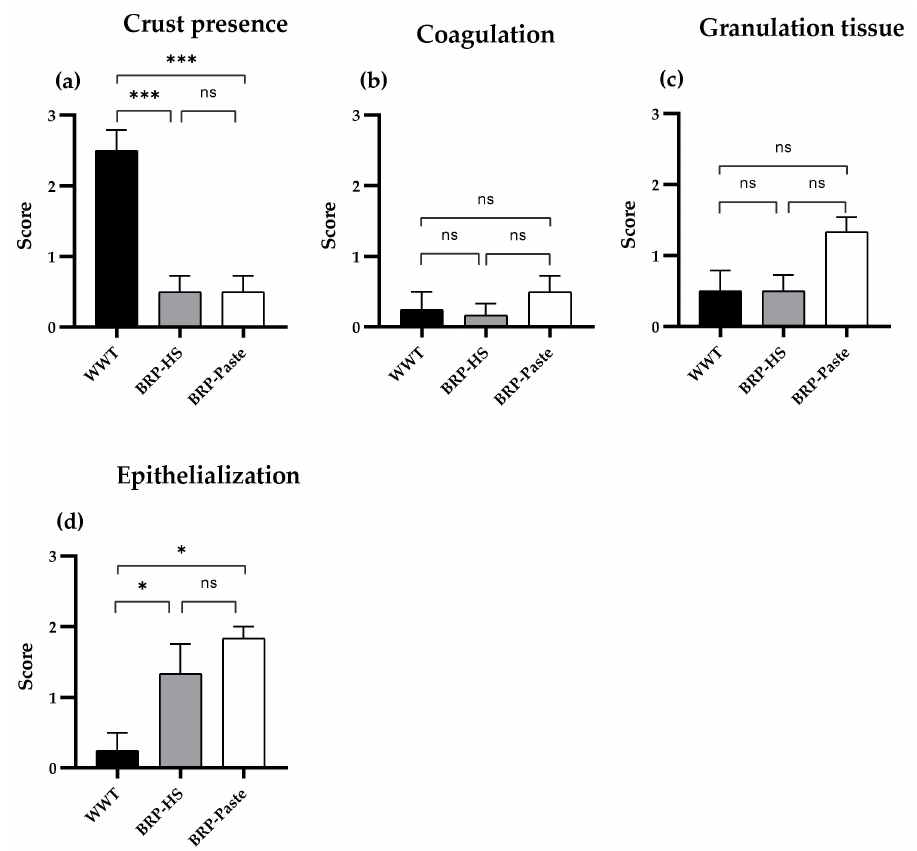
Figure 3. Clinical parameters appearance score of skin wounds after 14 days of treatment. Data shows macroscopical and qualitative evaluation of the clinical aspects of crust presence ( a ), coagulation ( b ), granulation tissue ( c ) and epithelialization ( d ) in which 0–absence (0%), 1–a little (30%), 2–fair (30–70%) e 3–very much (>70). Statistical analysis by Kruskal-Wallis test followed by Dunn’s test. * p < 0.05, *** p < 0.001 and ns = no significance compared to the WWT group ( n = 6). WWT: wounded animals without treatment; BRP-HS: hydroalcoholic solution with 1% Brazilian red propolis treatment; BRP-Paste: paste with 1% red propolis